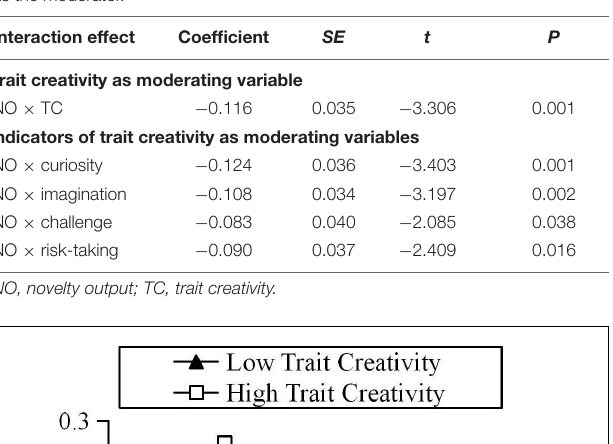
between novelty input and boredom ( β = − 0.069, p = 0.100; β = − 0.066, p = 0.094).